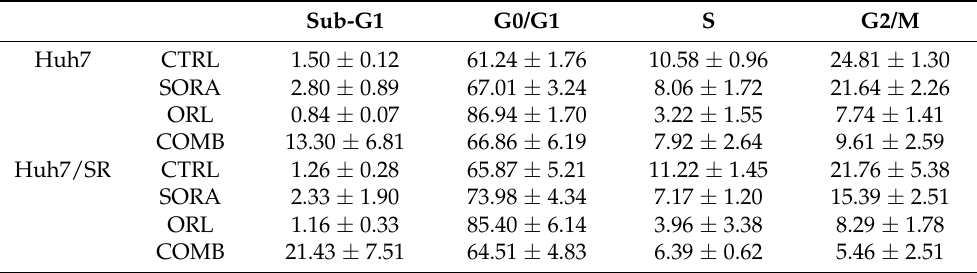
Table 1. The percentages of cells in each cell cycle phase in both Huh7 and Huh7/SR cells. Sub-G1 G0/G1 S G2/M Huh7 CTRL 1.50 ± 0.12 61.24 ± 1.76 10.58 ± 0.96 24.81 ± 1.30 SORA 2.80 ± 0.89 67.01 ± 3.24 8.06 ± 1.72 21.64 ± 2.26 ORL 0.84 ± 0.07 86.94 ± 1.70 3.22 ± 1.55 7.74 ± 1.41 COMB 13.30 ± 6.81 66.86 ± 6.19 7.92 ± 2.64 9.61 ± 2.59 Huh7/SR CTRL 1.26 ± 0.28 65.87 ± 5.21 11.22 ± 1.45 21.76 ± 5.38 SORA 2.33 ± 1.90 73.98 ± 4.34 ORL 1.16 ± 0.33 8.29 ± 1.78 COMB 21.43 ± 7.51 64.51 ± 4.83 6.39 ± 0.62 5.46 ±